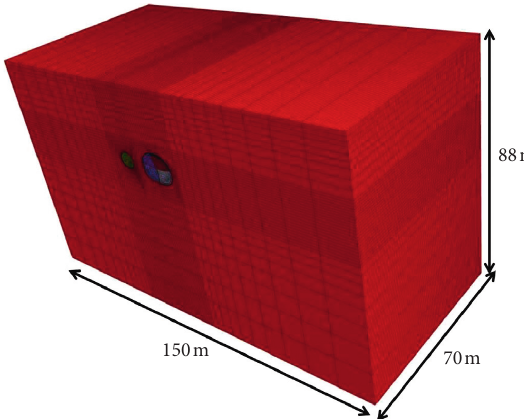
Figure 19: Numerical calculation model.